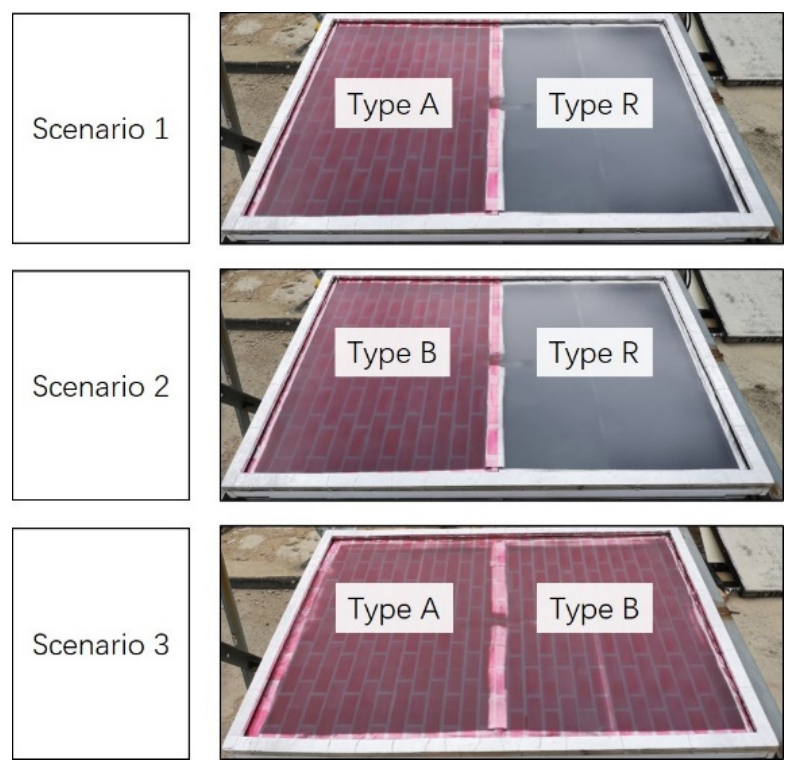
Figure 3. The relationship between the scenarios and the types.